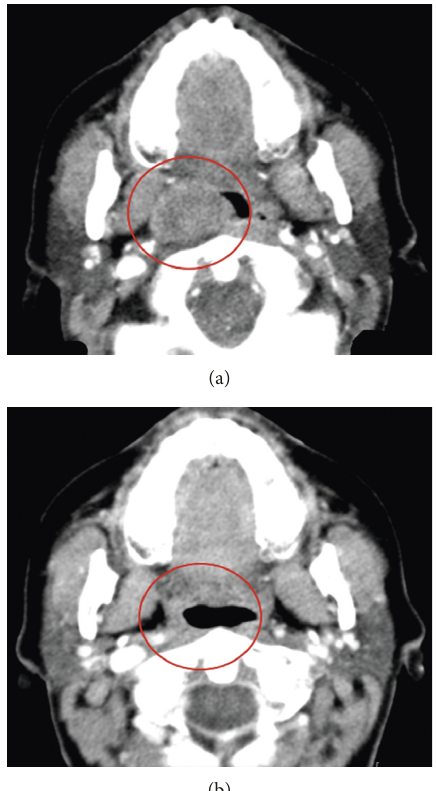
Figure 1: Changes in tumor size in patient 1. A CTscan of the neck, performed at the time of the second recurrence, showing an en- dophytic mass, with 3.1 × 2.2cm, on the right oropharyngeal wall, with reduction of its caliber (a). Recent reevaluation showing sustained complete response to vemurafenib, 34 months after starting the treatment